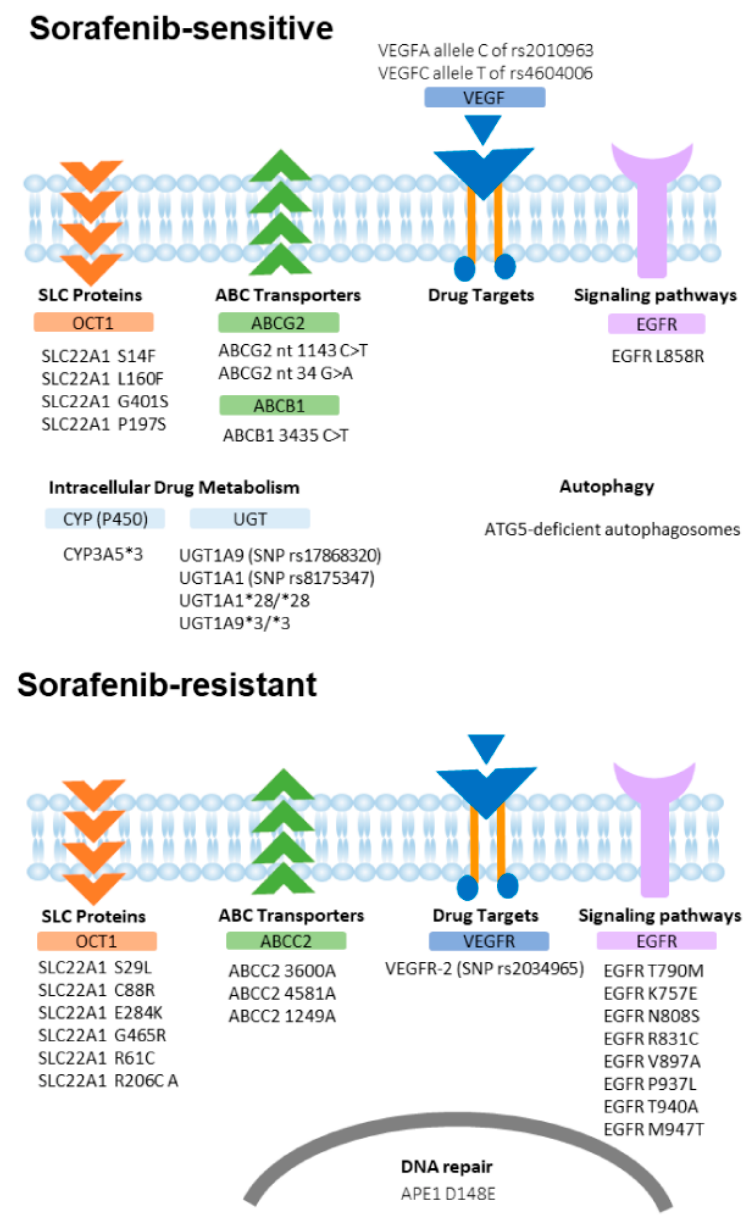
Figure 1. Genetic polymorphisms and variants on drug-resistant molecules in hepatocellular carcinoma. Several reported DNA polymorphisms and protein variants reportedly played role in sorafenib sensitivity (upper panel) and sorafenib resistance (lower panel), including in ABC transporters, SLC proteins, autophagy, and DNA repair molecules. Table 1. Mechanisms of resistance against sorafenib in HCC .